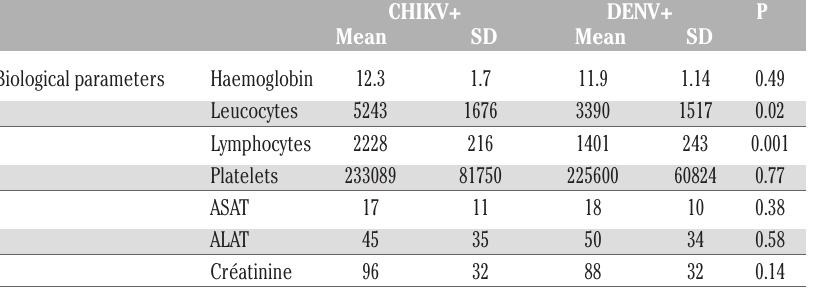
Table 2. Comparison of biological parameters between Chikungunya and Dengue-infect- ed patients during the 2010 outbreak in